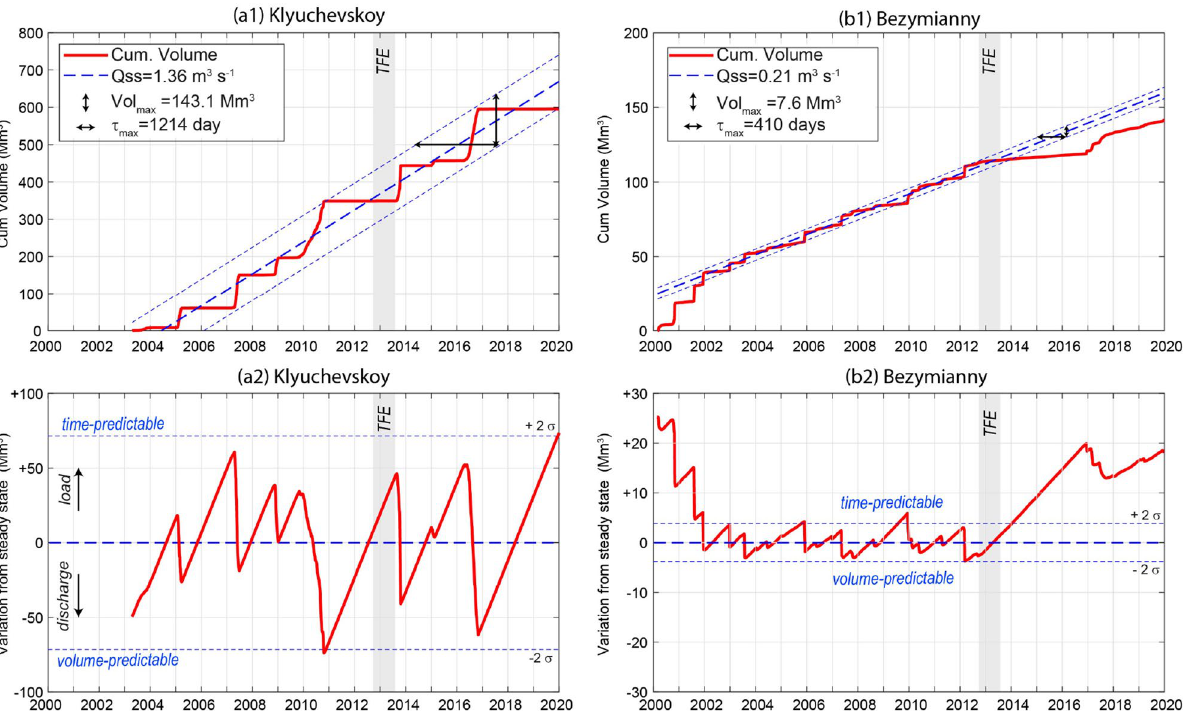
Figure 3. Upper panels. Cumulative volume curves for ( a1 ) Klyuchevskoy and ( b1 ) Bezymianny, derived from satellite measurements (see “Methods”). The linear fits of each cumulative curve represent the linear growth model (blue thick dashed lines) and provide the steady-state output rate (Q ss ). The two parallel lines (linear model ± 2σ) define the maximum eruptible volume (Vol max ) and the maximum response time (τ max ) for the inferred steady-state condition. Lower panels . Load and discharge model for ( a2 ) Klyuchevskoy and ( b2 ) Bezymianny. The variation from the steady-state is calculated as the residual between the linear growth model and the observed cumulative volume curves. A two-fold standard deviation (± 2σ) of residual is used to define the upper and lower volume limits for the load-discharge model. In this plot, a time-predictable system would have a near-constant upper threshold of the volume load when eruptions occur. A volume-predictable system would have a near-constant lower threshold. An entirely predictable system would have both. The gray bar indicates the timing of the 2012 Tolbachik Fissure Eruption (TFE). Time series generated using MATLAB software (www. mathw orks.